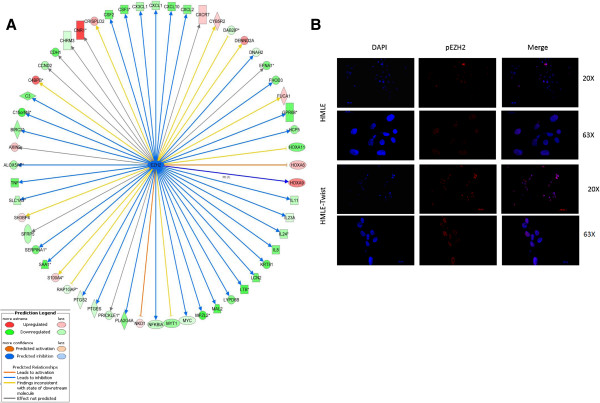
Phosphorylation of serine residue 21 of EZH2 is increased following epithelial-mesenchymal transition. (A) Ingenuity Pathway Analysis showing inhibition of EZH2 as a potential upstream regulatory event following Twist-induced epithelial-mesenchymal transition. Overall, 37 target genes were predicted to be inhibited by EZH2. (B) Immunofluorescence showing increase of phosphorylation of EZH2 at serine residue 21 in human mammary epithelial (HMLE) Twist cells as compared to HMLE vector cells.